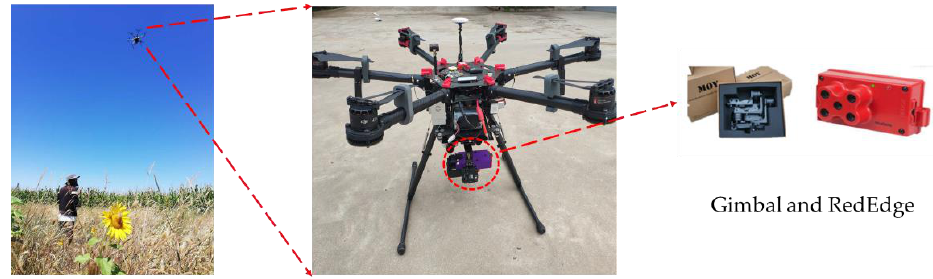
Figure 3. Schematic diagram of the UAV multispectral remote sensing system developed in this study.